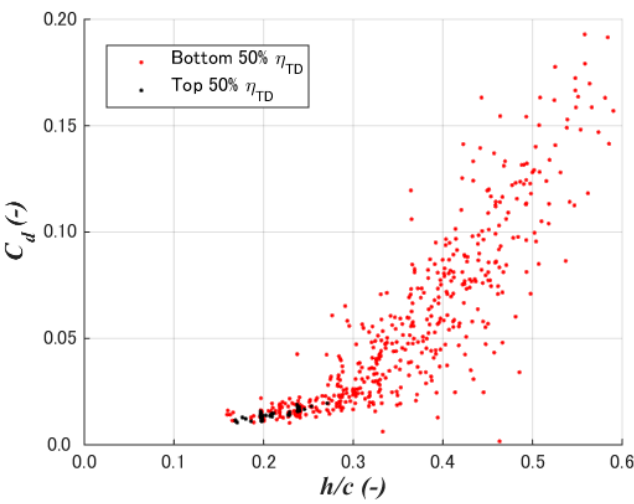
Figure 14. Drag coefficient to diffuser height.